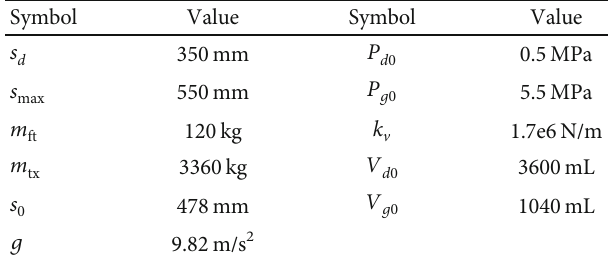
Table 1: Simulation